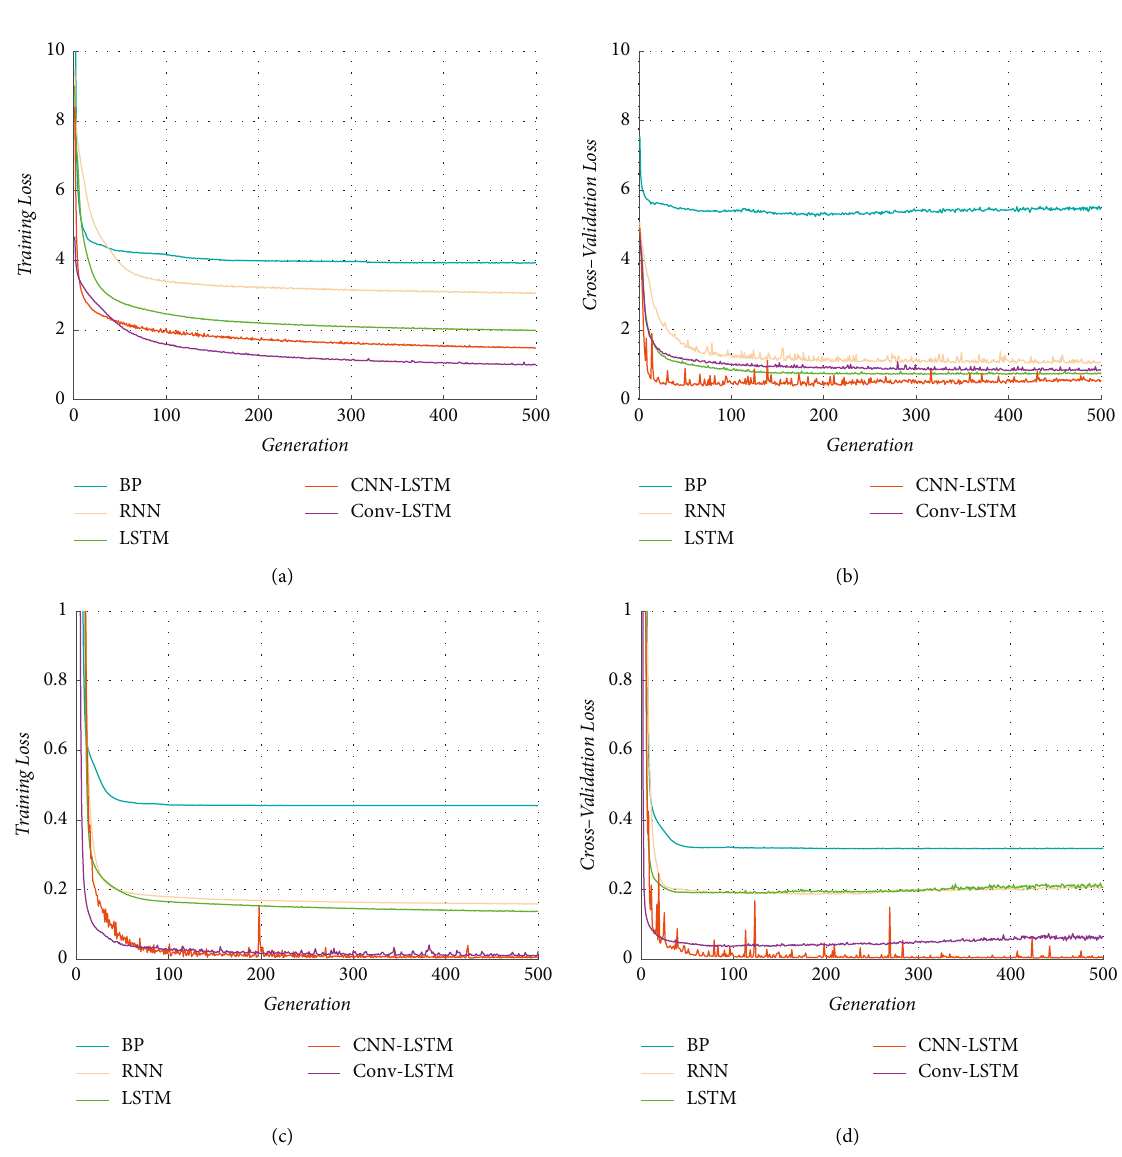
Figure 9: Training loss and validation of ANN CF models. (a) Training loss of ANN CF-A. (b) Cross-validation loss of ANN CF-A. (c) Training Los of ANN CF-V. (d) Cross-validation of ANN